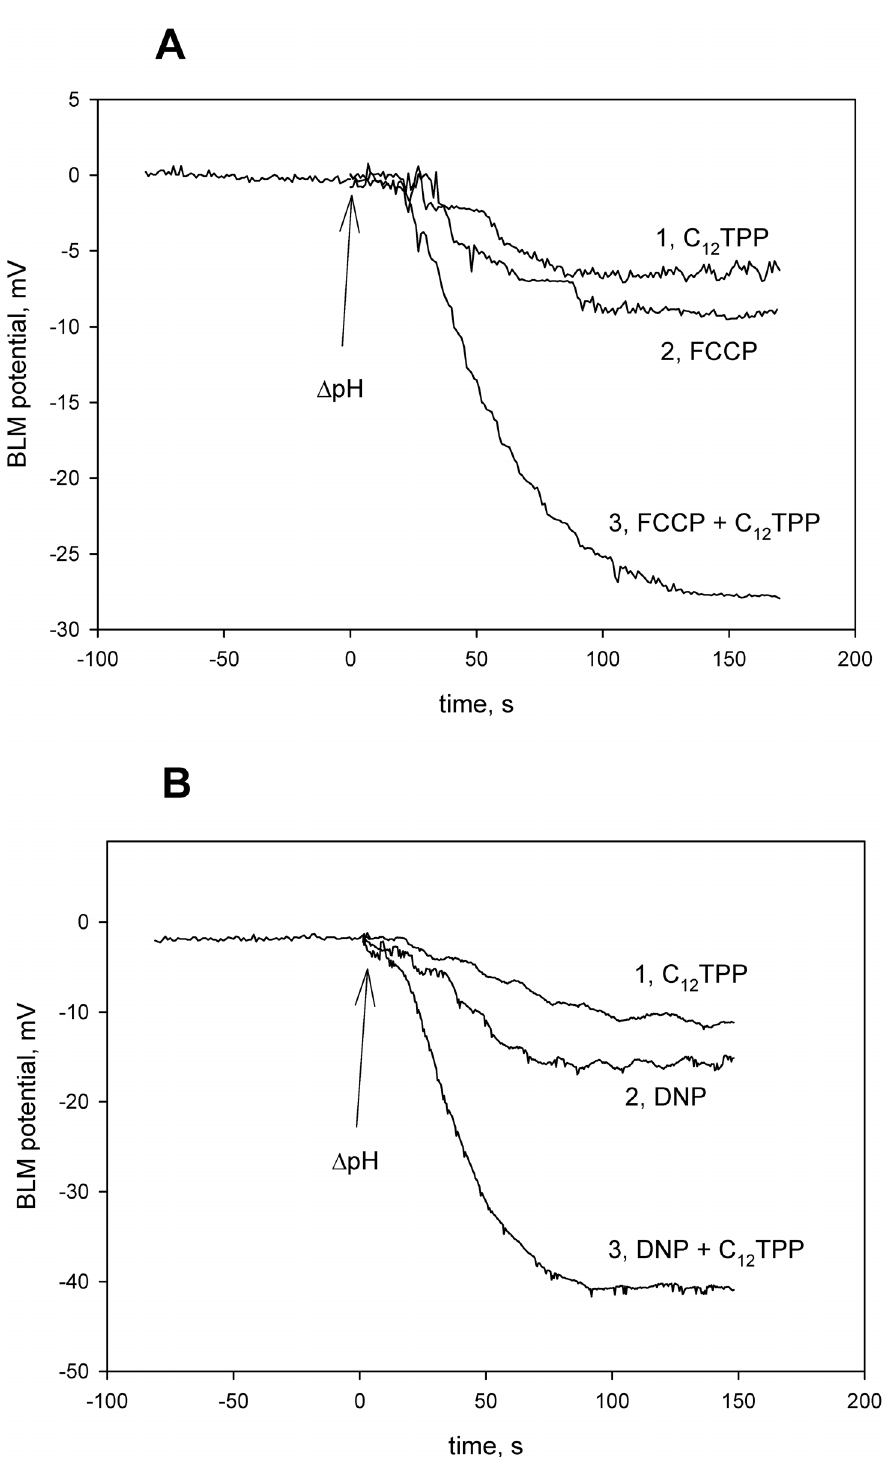
Figure 2. C 12 TPP enhances protonophorous effect of 2 nM FCCP (panel A) and 10 m M DNP (panel B) in bilayer lipid membrane (BLM). Diffusion potential was recorded upon the addition of KOH in one compartment to create D pH=1. Incubation mixture, 10 mM Tris, 10 mM MES, 10 mM KCl, pH 7; C 12 TPP, 0.1 m M. Control, a record without C 12 TPP and uncouplers. Plus sign of the potential in the compartment of high pH.